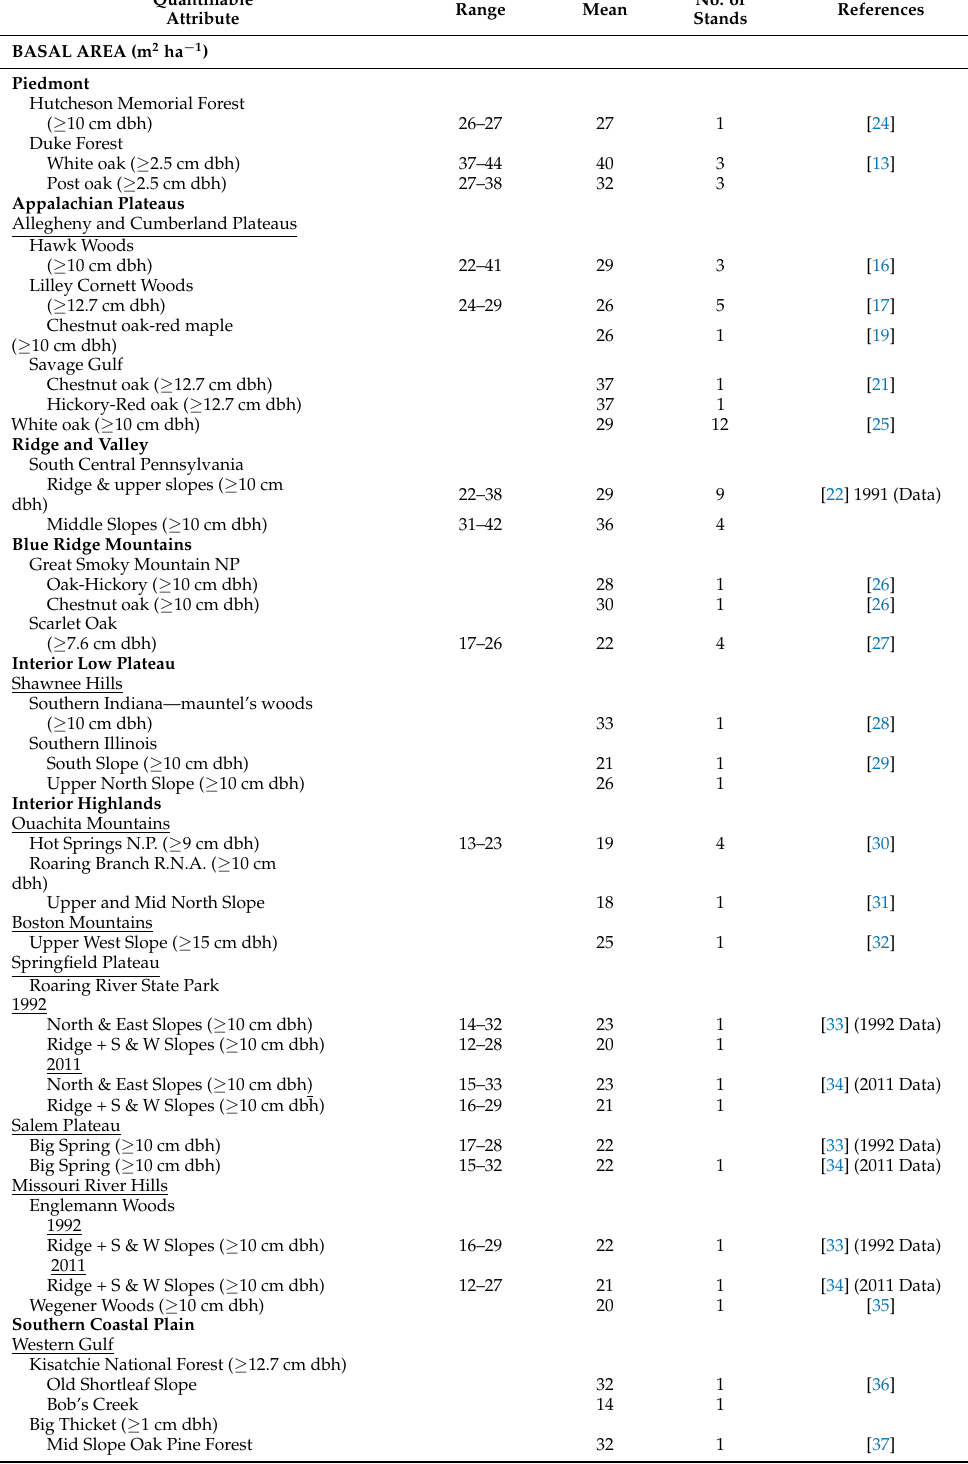
Table 2. Basal area (m 2 ha − 1 ) of representative dry-mesic old-growth oak forests. Quantifiable Attribute